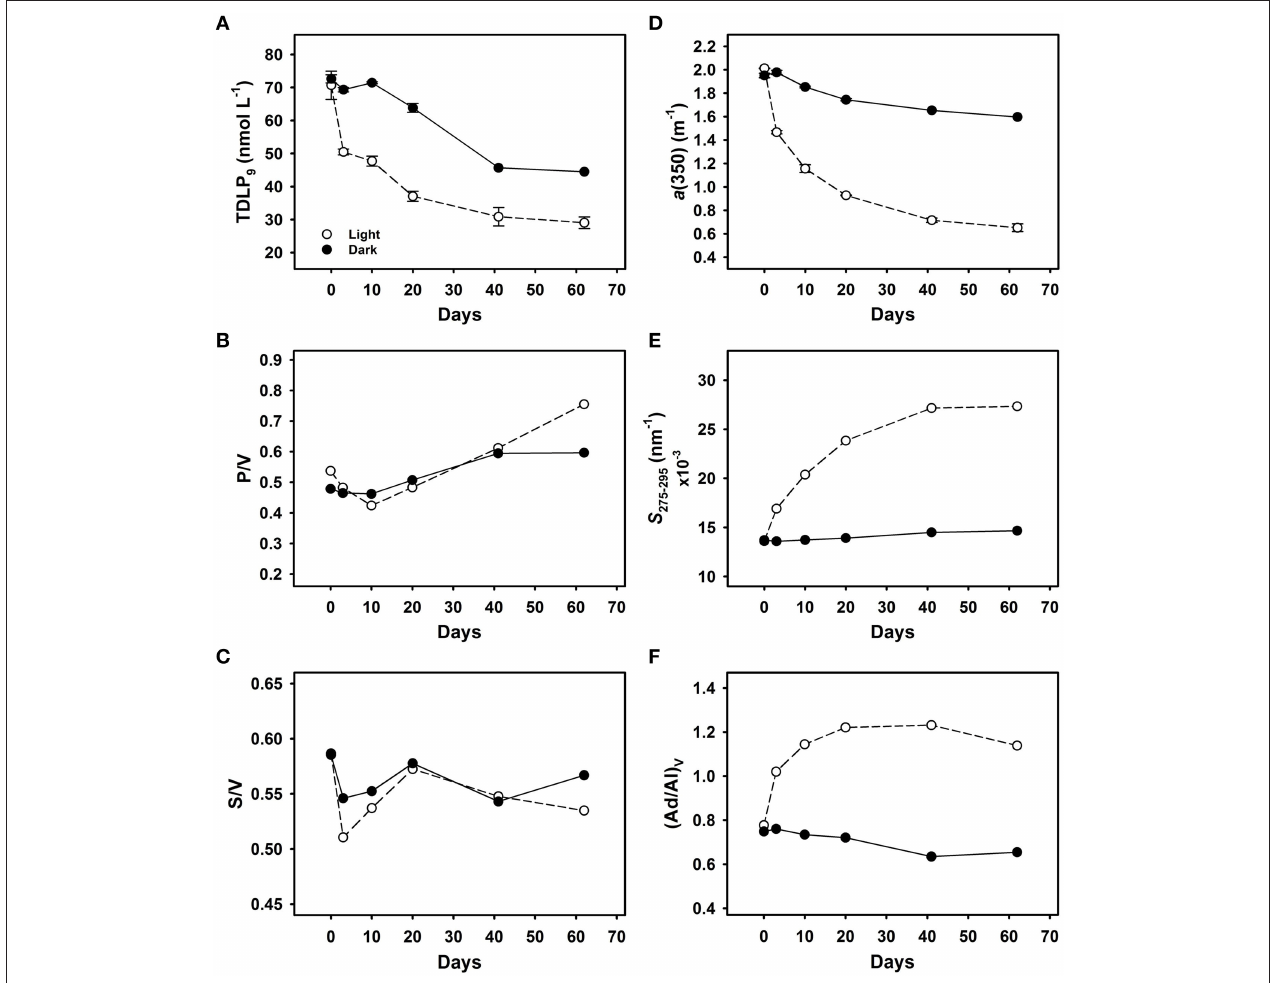
FIGURE 7 | Photochemical and biological degradation of DOM in Unosumai River water. Time-course changes in (A) lignin phenol concentrations (TDLP 9 ), (B) lignin phenol P/V composition, (C) lignin phenol S/V composition, (D) CDOM absorption coefficient a (350), (E) spectral slope S 275 − 295 , and (F) lignin phenol (Ad/Al) V composition. Experiments were conducted with duplicate samples incubated under natural sunlight (light treatment; photochemical and biological processes; open circles) and duplicate samples wrapped in aluminum foil (dark treatment; biological processes; closed circles). Plots are presented as average value ± range of duplicate